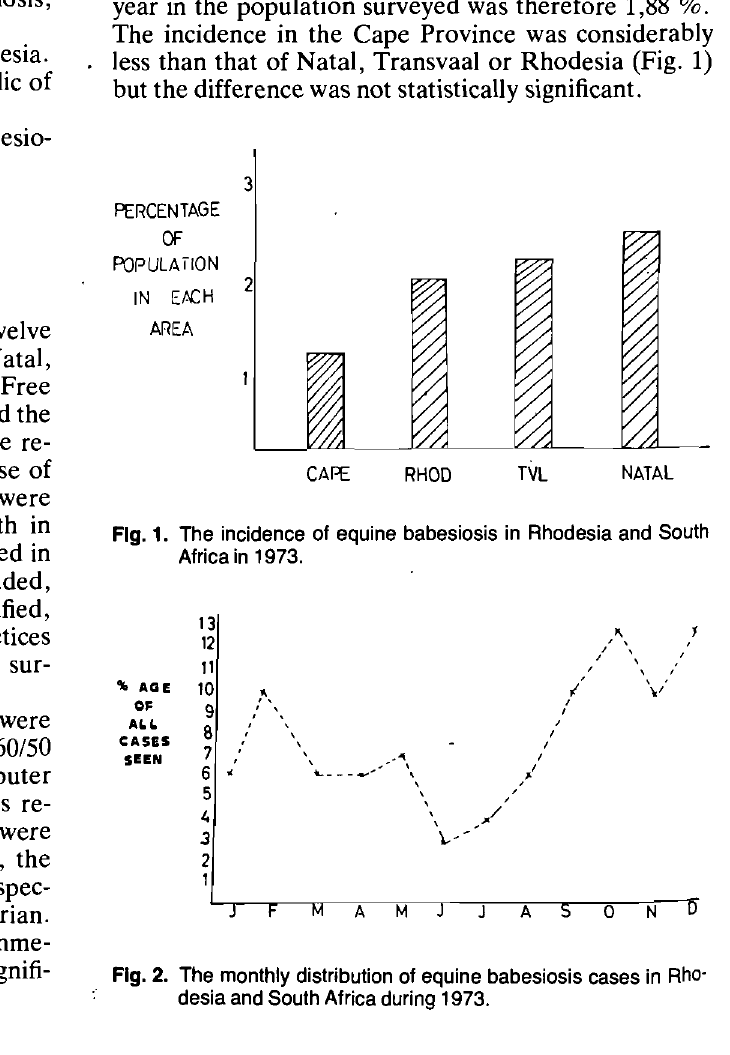
Fig. 2. The monthly distribution of equine babesiosis cases in Rho' desia and South Africa during 1973.